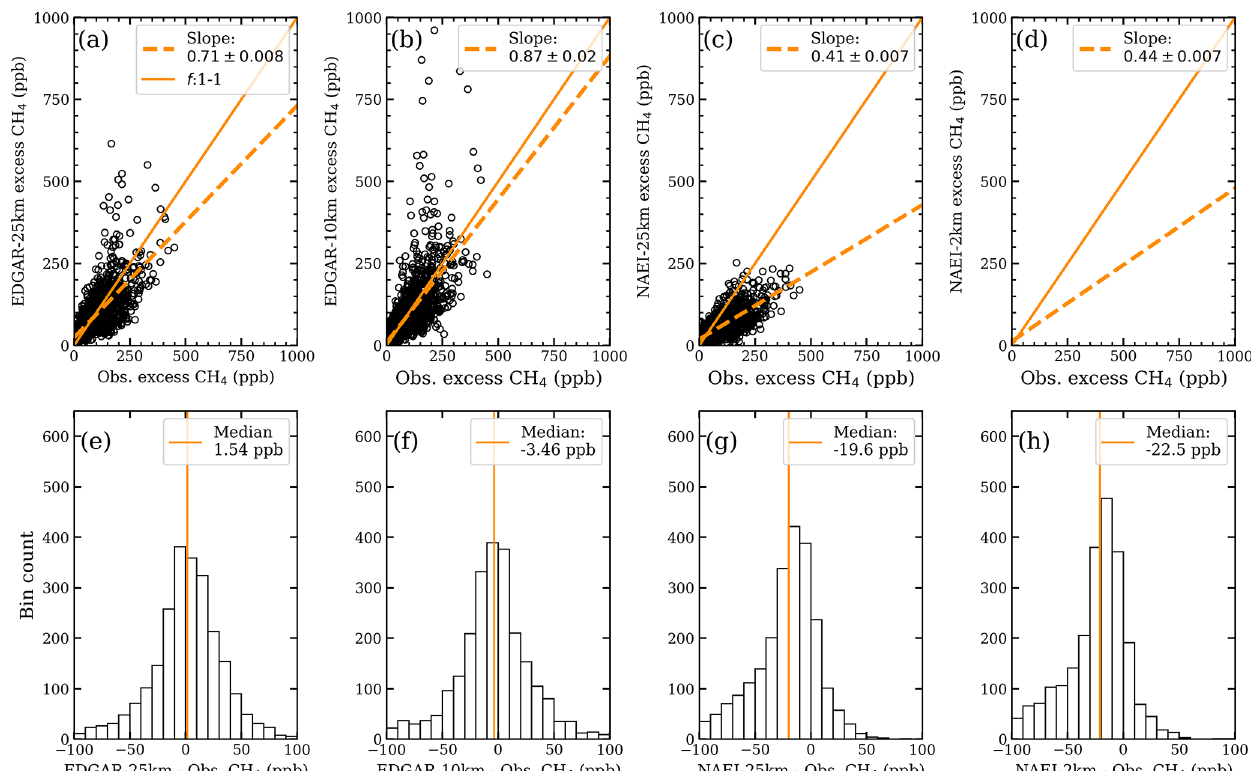
Figure 10. Simulation–observation comparisons of excess mole fractions using linear regressions (top row) and distributions of the simulation–observation differences (bottom row) for (a, e) EDGAR-25km, (b, f) EDGAR-10km, (c, g) NAEI-25km, and (d, h)